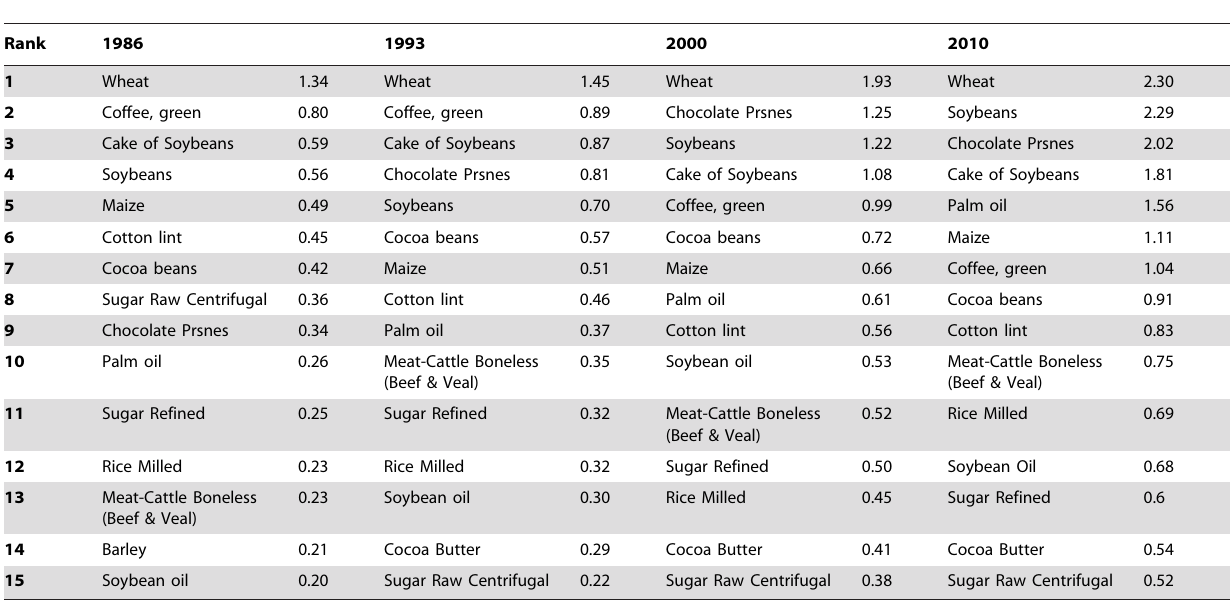
Table 2. The top 20 products and corresponding virtual water flux (10 11 m 3 ) for the years 1986, 1993, 2000 and 2010.